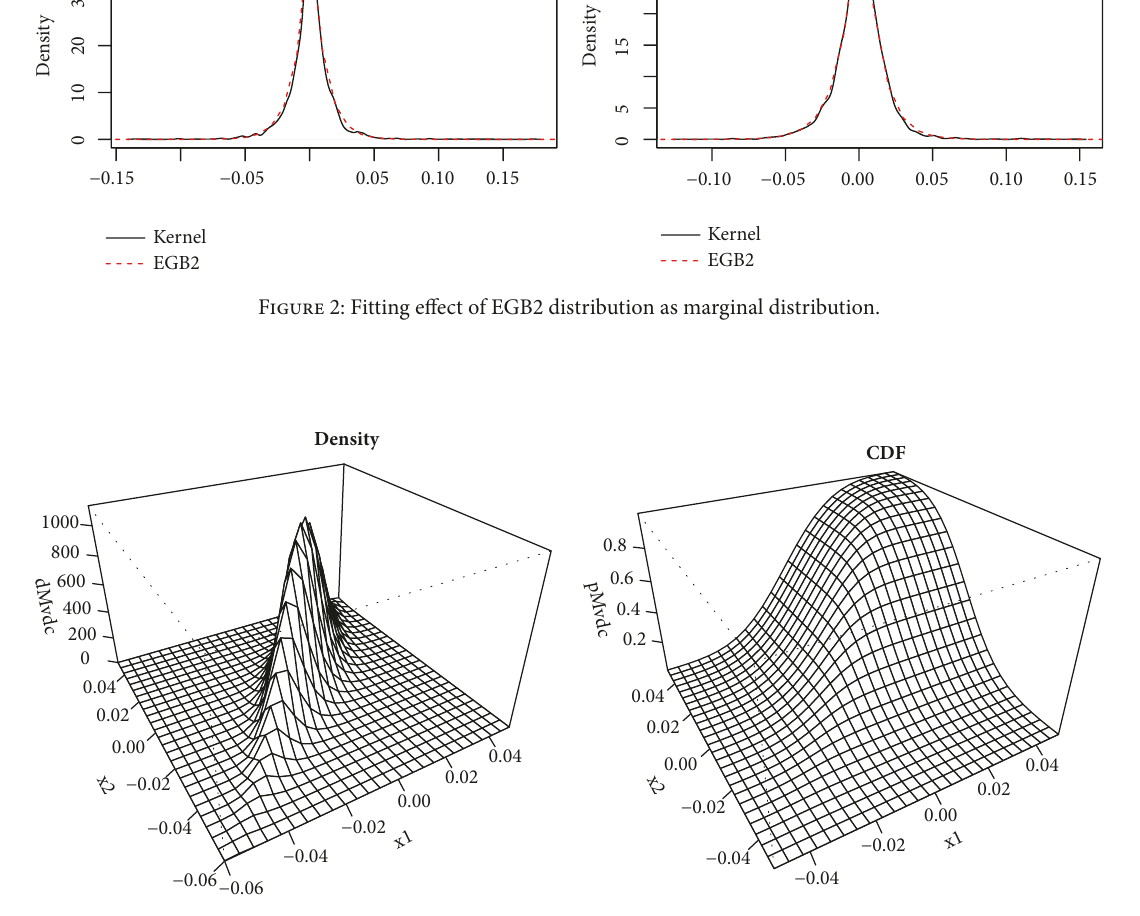
Figure 3: The p.d.f and c.d.f of the MEGB2 copula with EGB2 marginals.